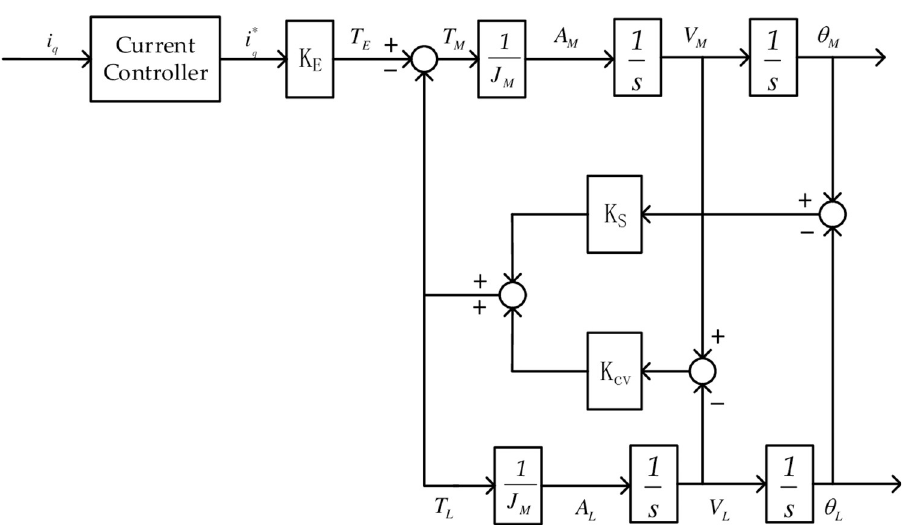
Fig 3. Servo system two-mass model transfer function block